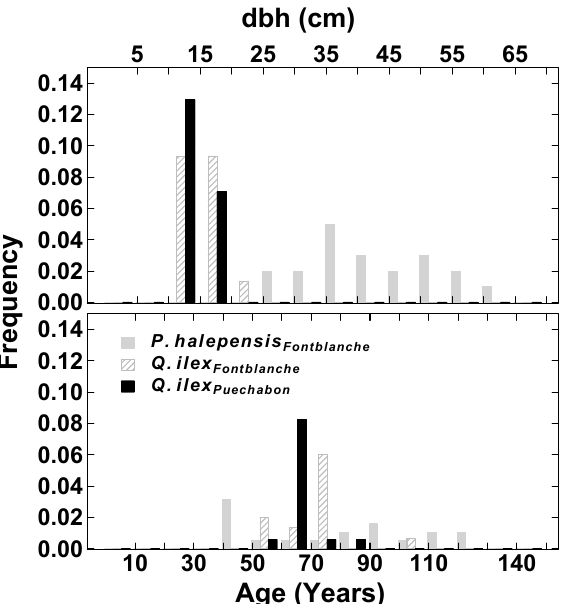
Figure A2. Diameter (dbh, cm) and age (years) distribution of trees included in the chronologies. Frequencies are calculated separately by species and